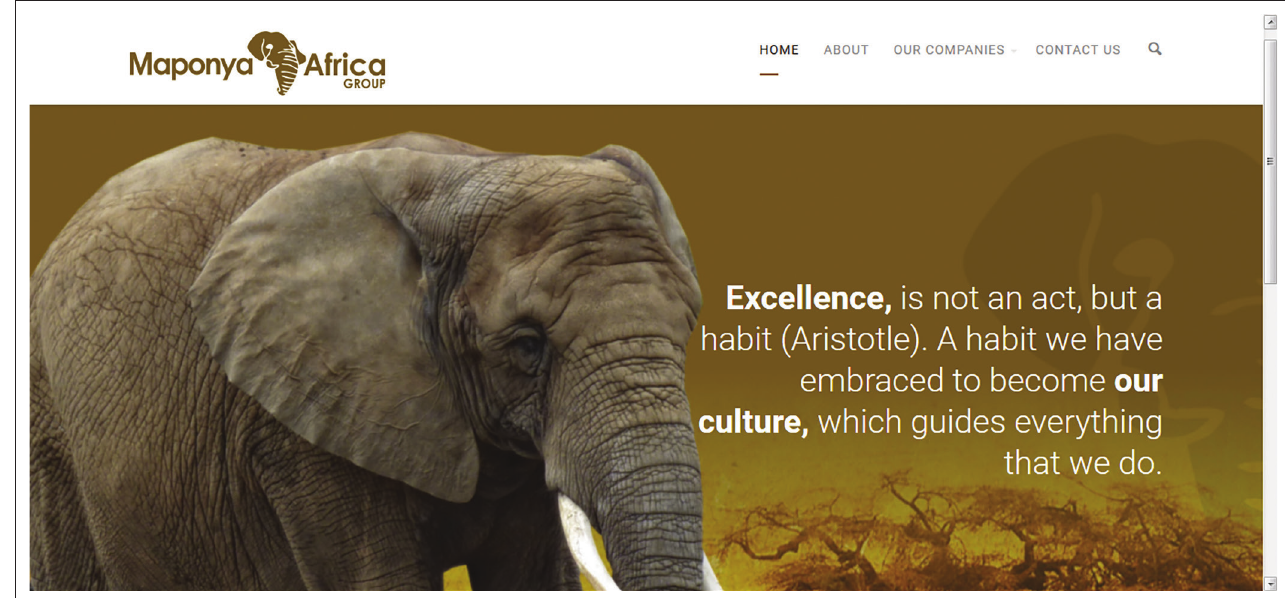
FIGURE 1: A website of a Maponya